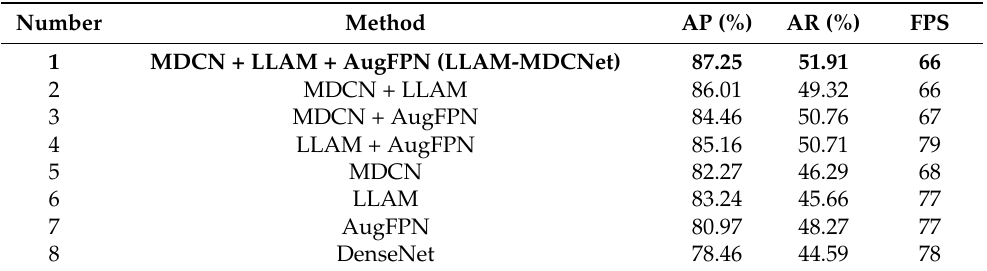
Table 1. Experimental statistics of ablation for remote sensing image target detection of dead and old trees using different sub-modules in